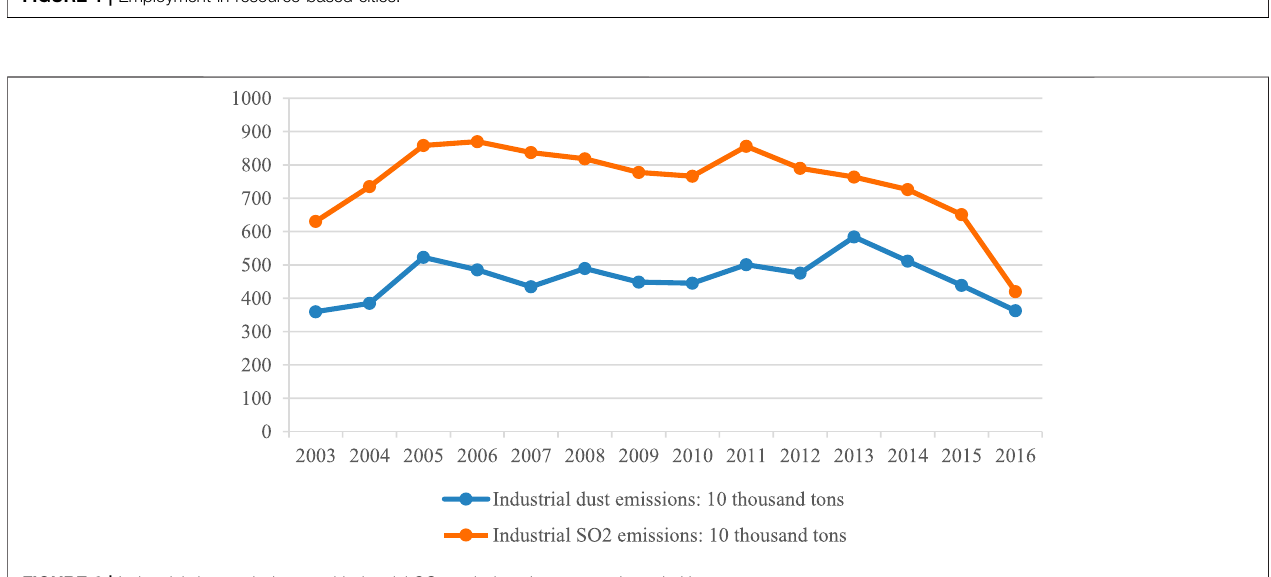
FIGURE 2 | Industrial dust emissions and industrial SO 2 emissions in resource-based